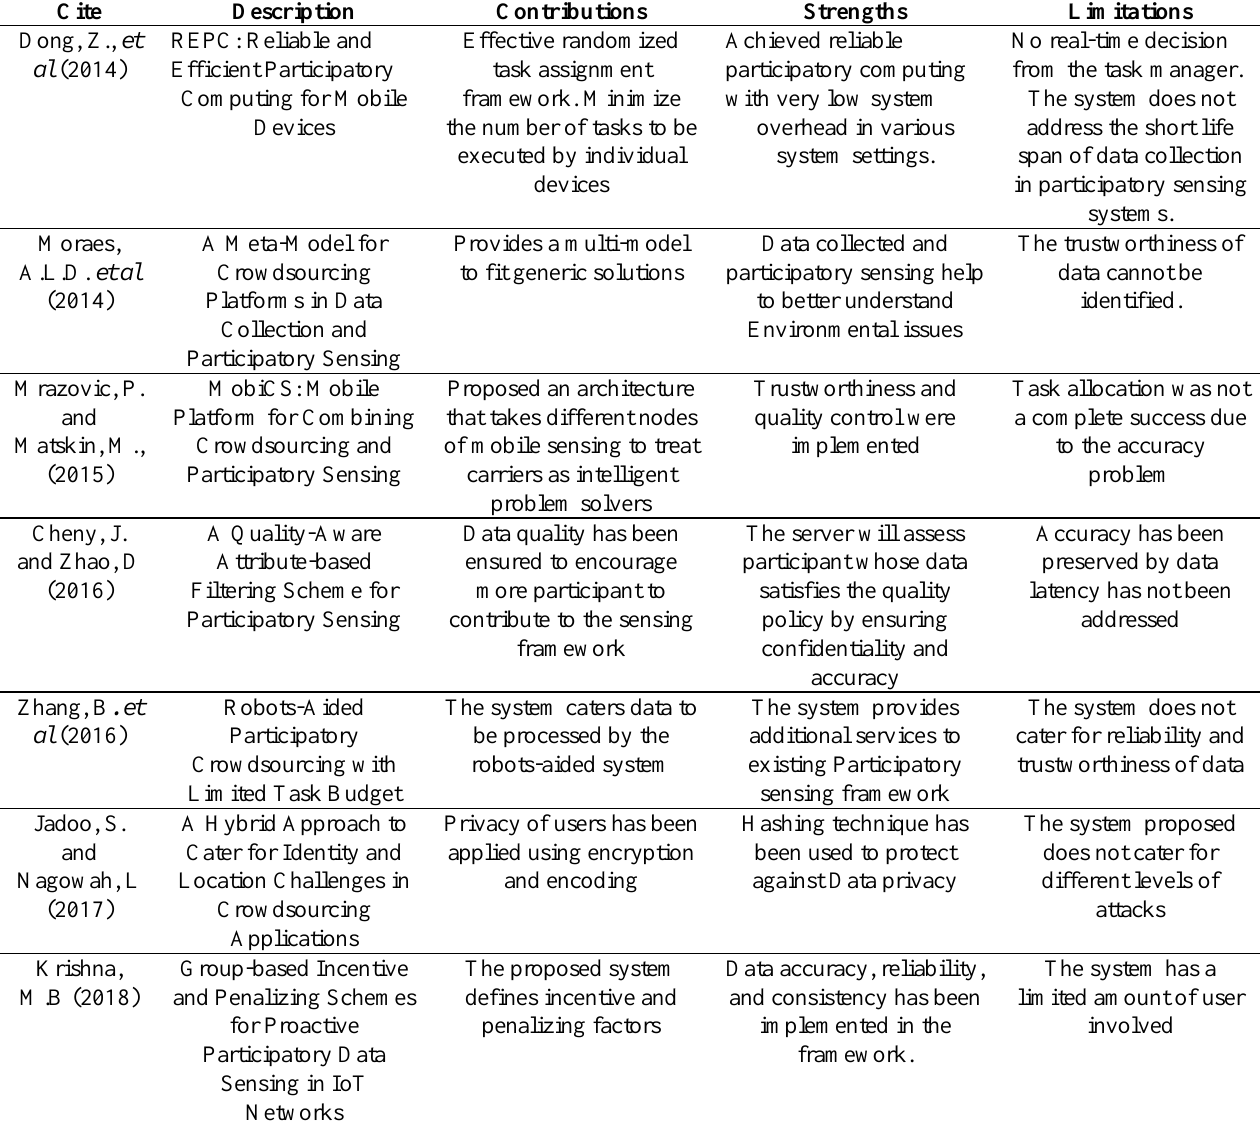
Table 4. Task-Oriented Participatory Sensing